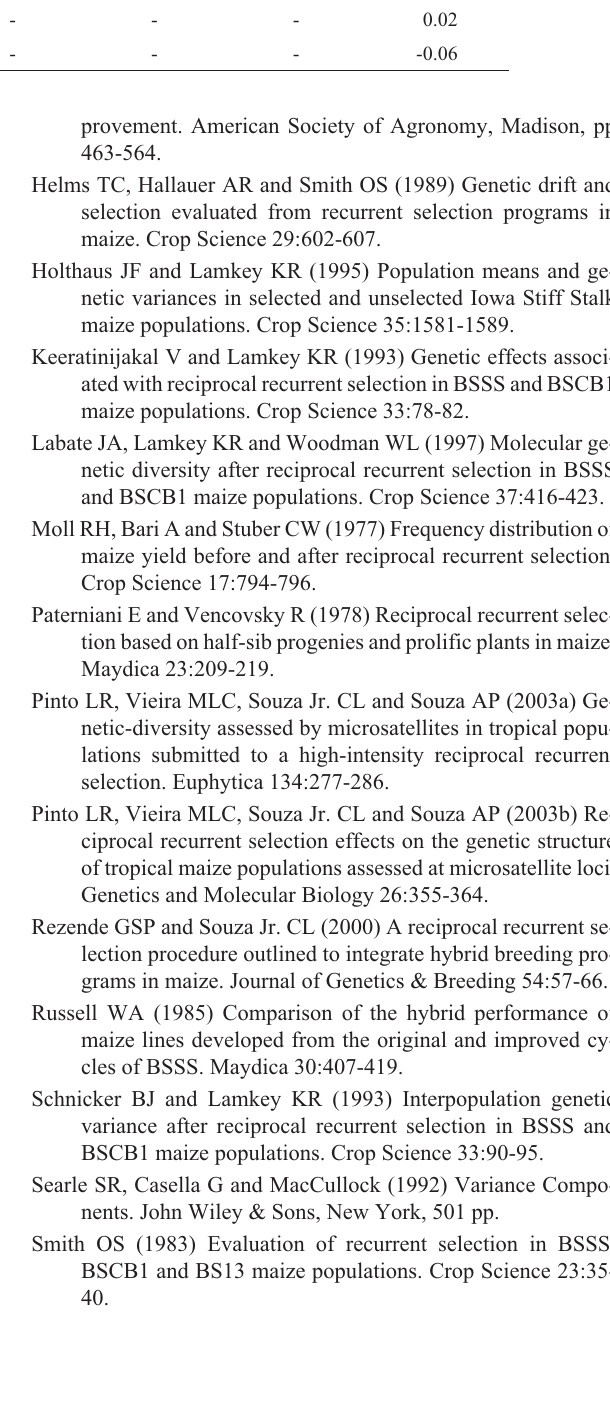
Table 5 - Estimates of the genetic correlations between traits for original (C Traits